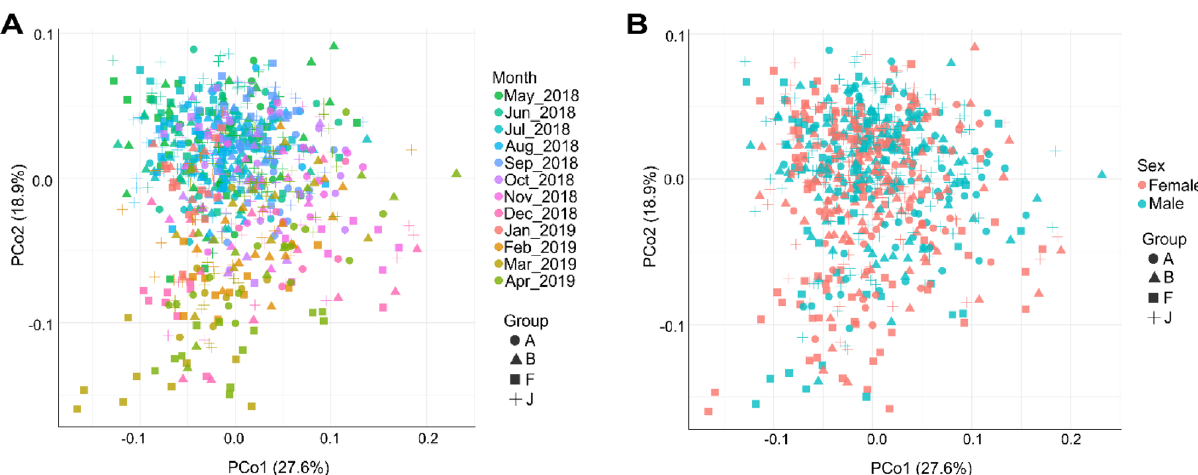
Figure 3. PCoA from Weighted Unifrac matrices of the bacterial community denoting beta diversity changes. ( A ) Data points color coded for the different study months to depict monthly changes in beta diversity. ( B ) Data points color coded for sex. Groups are depicted in A and B by